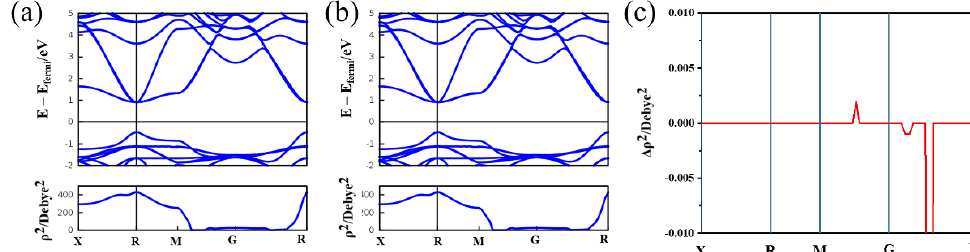
Figure 3. The electronic band structure and transition dipole moment. The upper of ( a , b ) is the electronic band structure under 0 and 10 kPa, respectively, and the bottom of ( a , b ) is the transition dipole moment. ( c ) The transition dipole moment difference between 0 and 10 kPa.